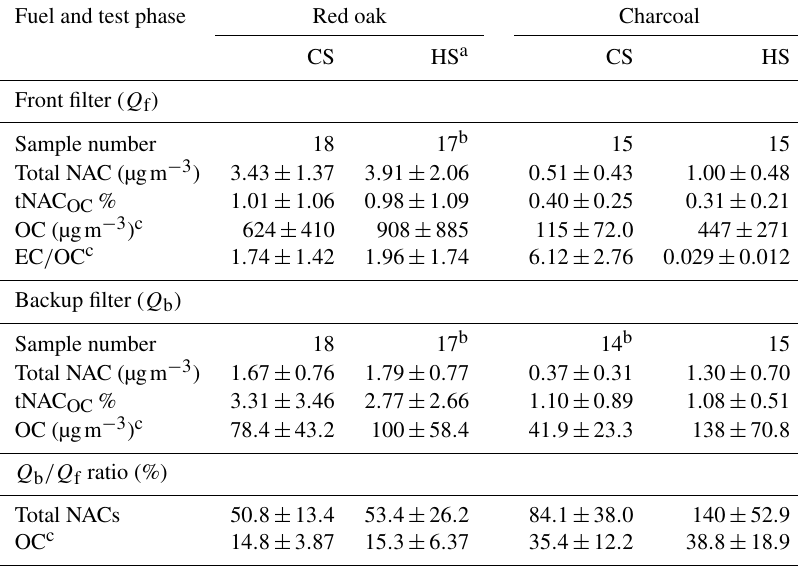
Table 1. Average concentrations of total NACs and tNAC OC % in Q f and Q b samples by fuel type and WBT phase. Fuel and test phase Red